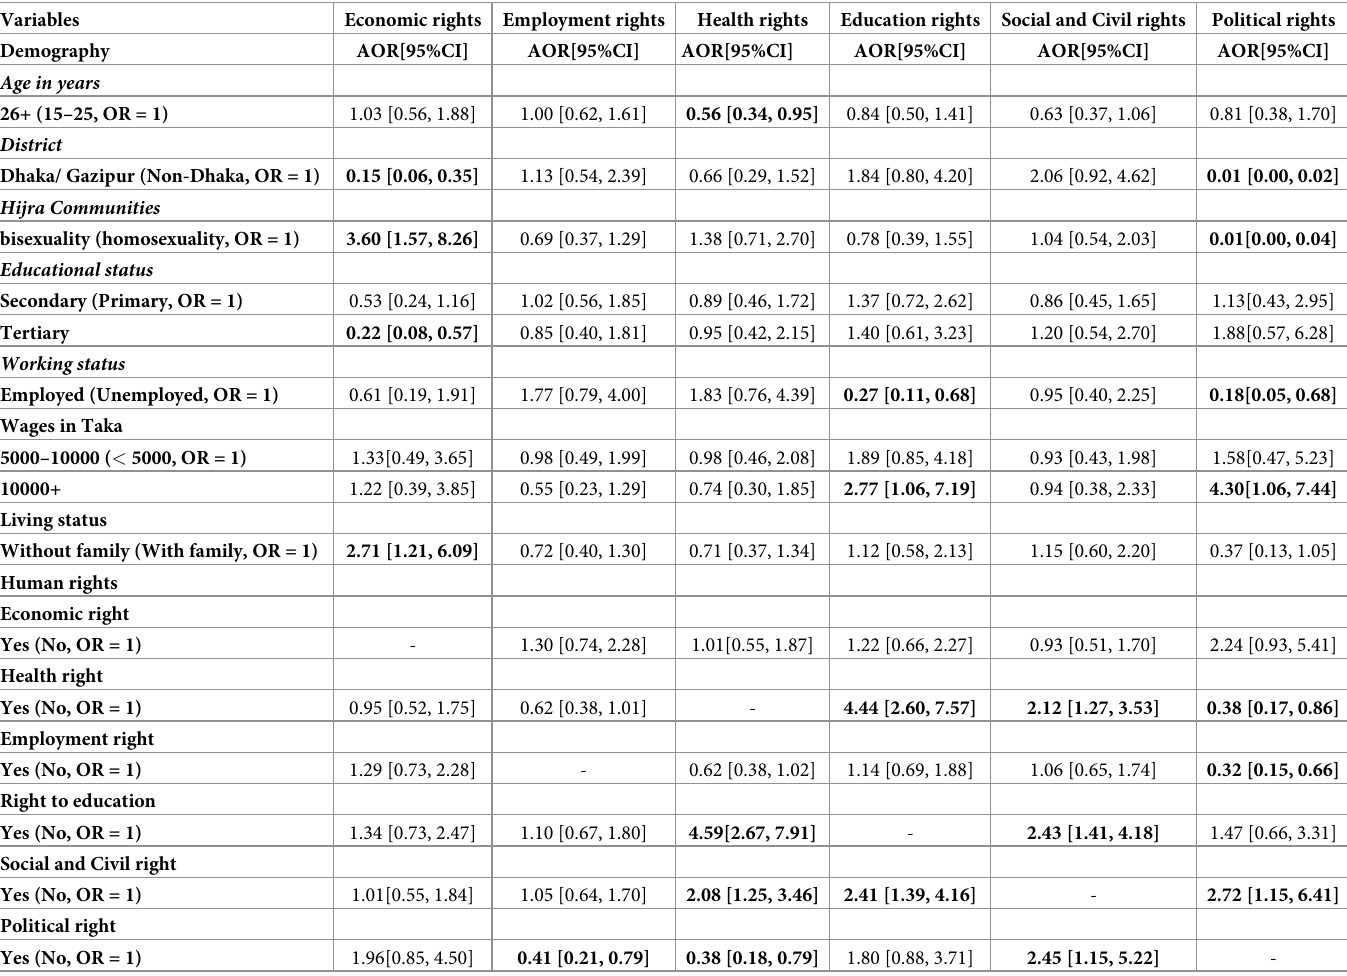
Table 4. Multiple logistic analyses of six human right violations in Bangladesh Hijras. Adjusted odds ratios (AOR) and 95% Confidence intervals (CI). Confidence Intervals (CI) that exclude 1.00 are statistically significant at p < 0.05 level and were bolded. Empty cells represent the human rights category that wasused as anoutcome variable for that model. The non-Dhaka districts included:Chattogram, Mymensingh, Narayanganj and Rajshahi